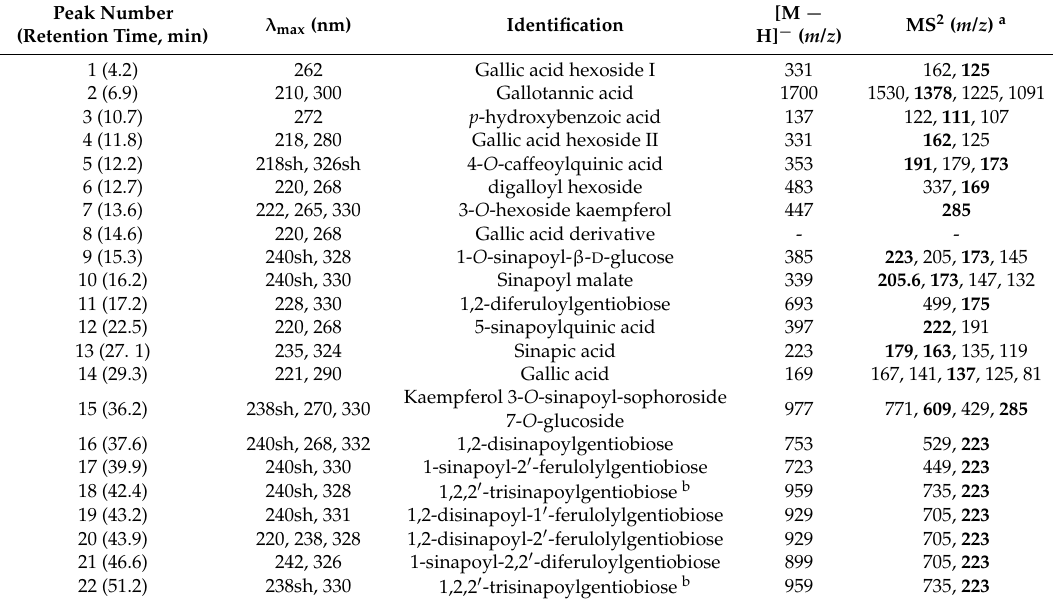
Table 3. Identification of individual phenolic compounds in broccoli sprouts. Identification was obtained by HPLC-DAD and HPLC-ESI-MS n